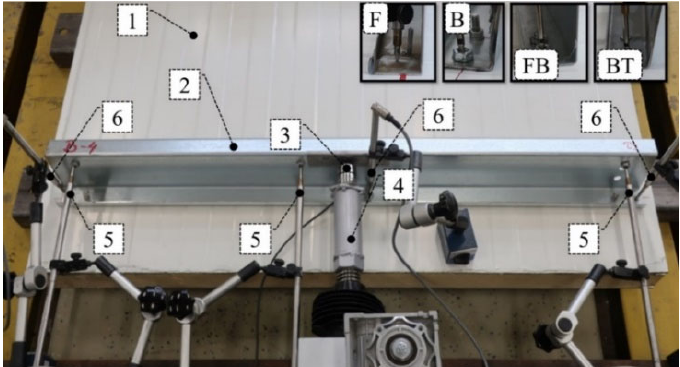
Figure 4. View of a test bed (description in text).